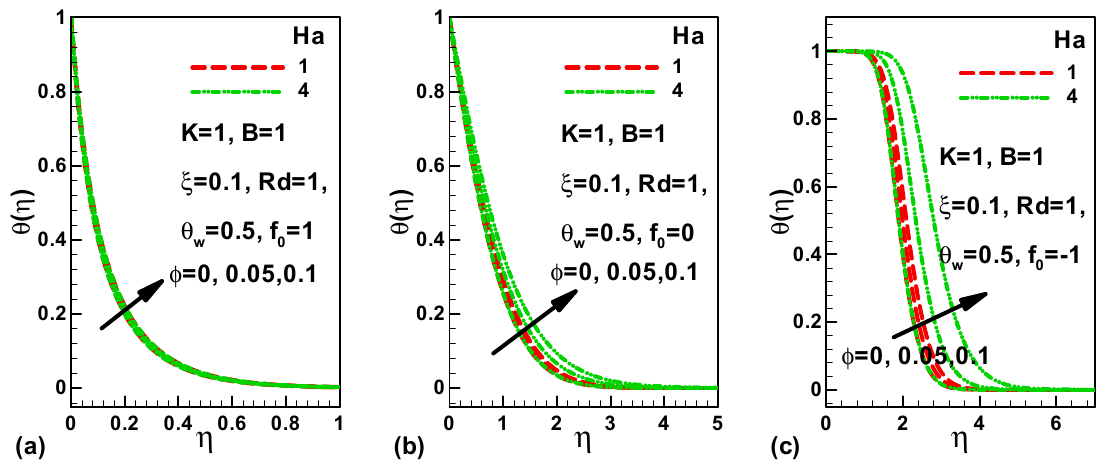
Figure 6. Effects of magnetic parameter and solid volume fraction of nanoparticles on dimensionless temperature along truncated cone for ( a ) suction, ( b ) impermeable, and ( c ) injection of kerosene-based magnetite nanofluid.